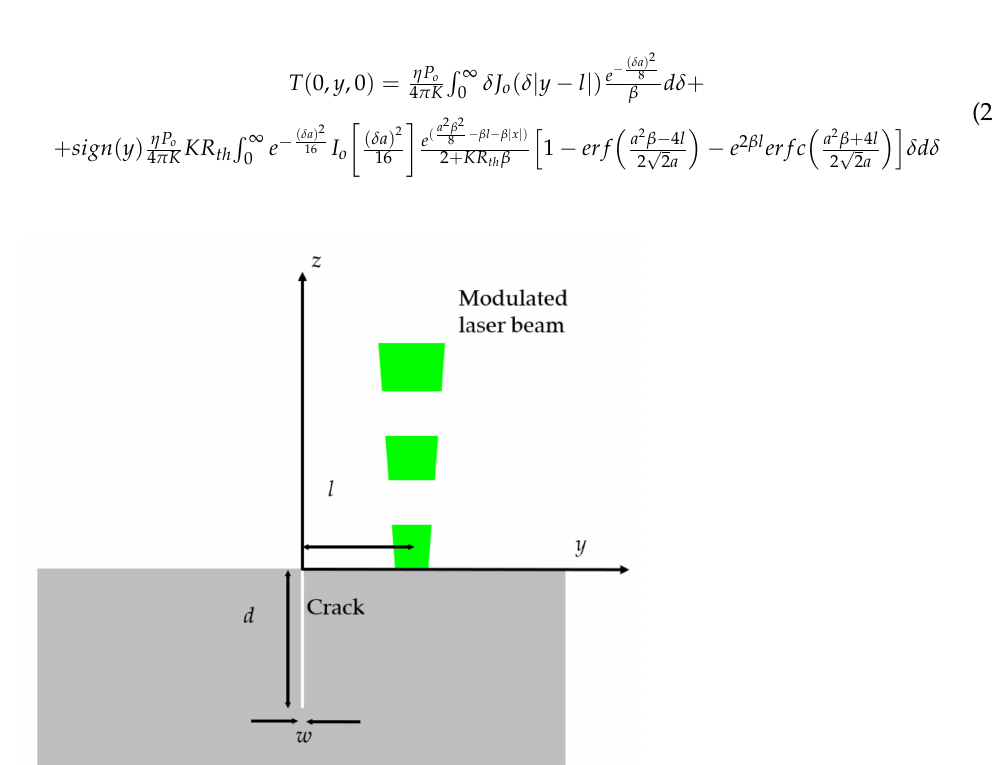
(cid:114) (cid:16) (cid:17) 2 i ω δ 2 + ; J o D